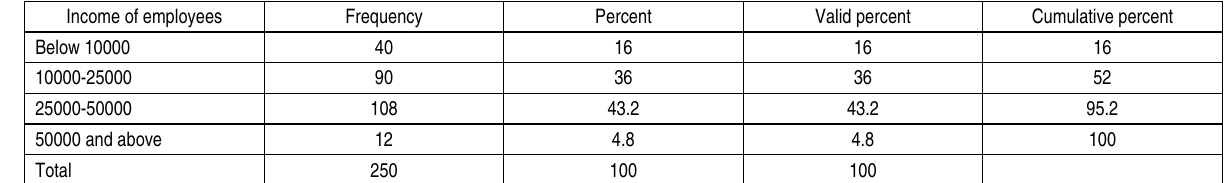
Table 4. Frequency and percentage of employees with respect to income